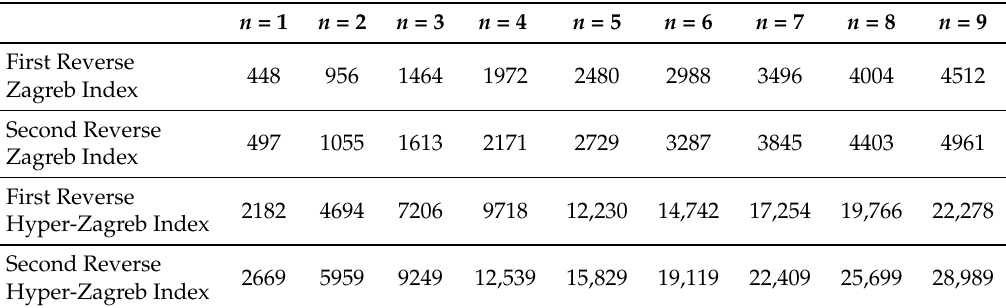
Table 1. Topological indices of D n P n